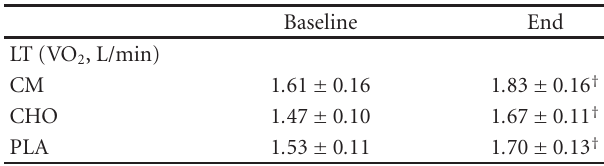
Figure 2: Oxidative enzyme activity. (a) Citrate synthase activity. (b) Succinate dehydrogenase activity. Biopsieswere takenat baseline (before starting the training period) and at the end of the 4.5wk Figure 1: VO 2 max changes after 4.5wks of aerobic endurance training period. No significant treatment di ff erences were found. † , training.(a) Changefrom baseline in absolute VO 2 max.(b) Change significant time e ff ect ( P < . frombaseline in relative VO 2 max.Valuesare mean ± SE. Significant treatment di ff erences: ∗ , CM versus PLA and CHO ( P < . 05). Table 4: Lactate threshold.